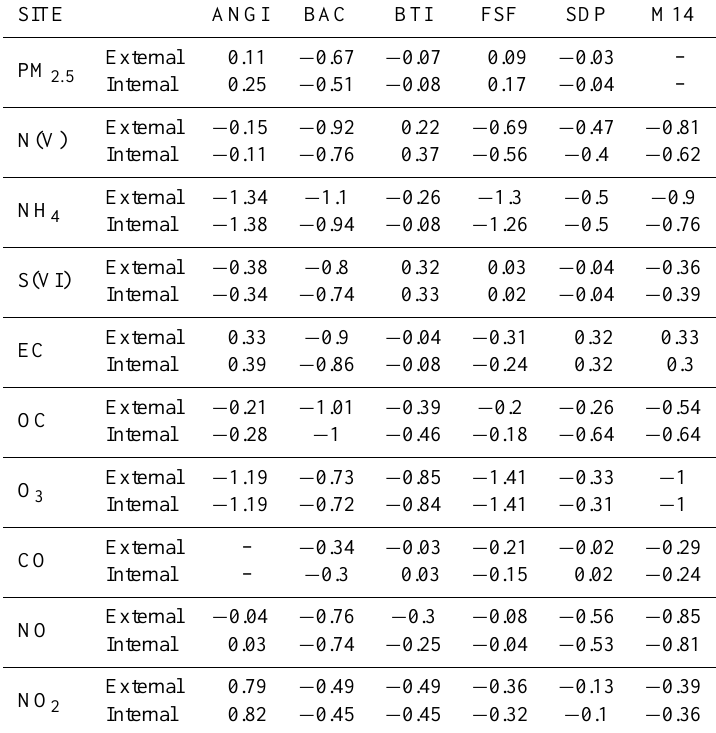
Table 4. MFB of PM and gas species predicted by the external run and internal run at 6 observation sites within the 4km domain.